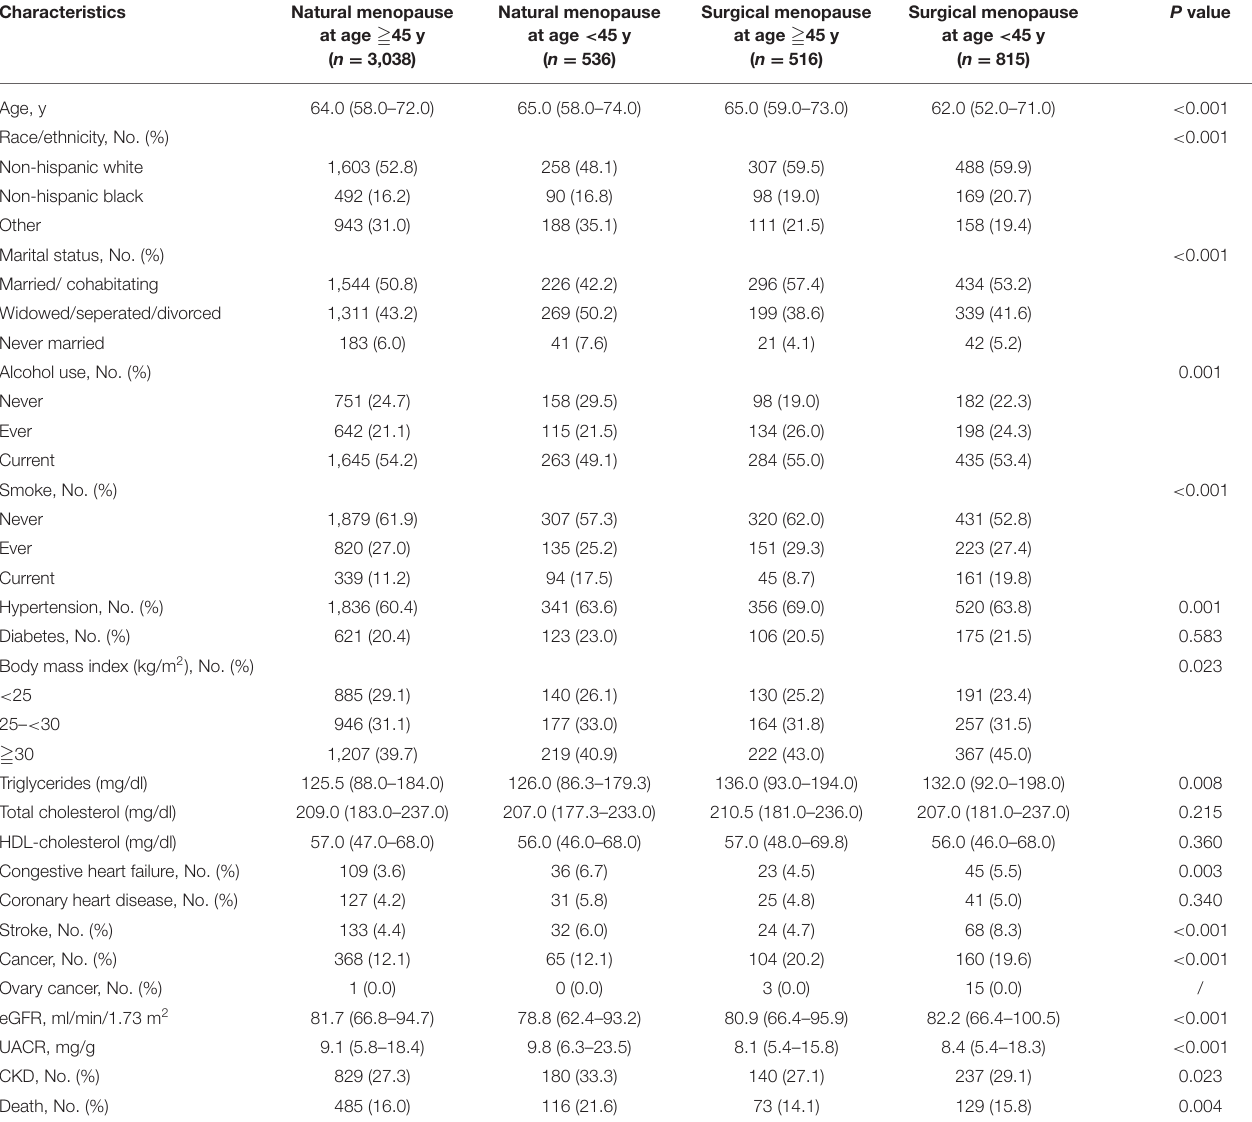
TABLE 1 | Characteristics of the participants.